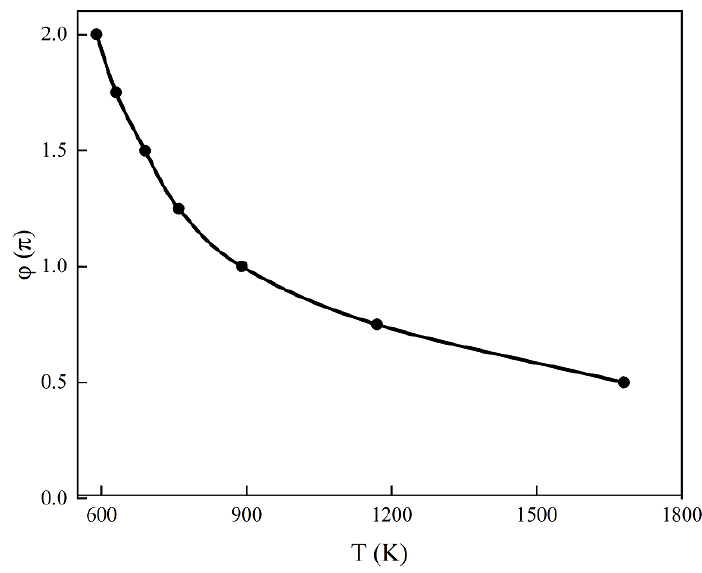
Figure 13. Phase delay corresponding to different temperatures.